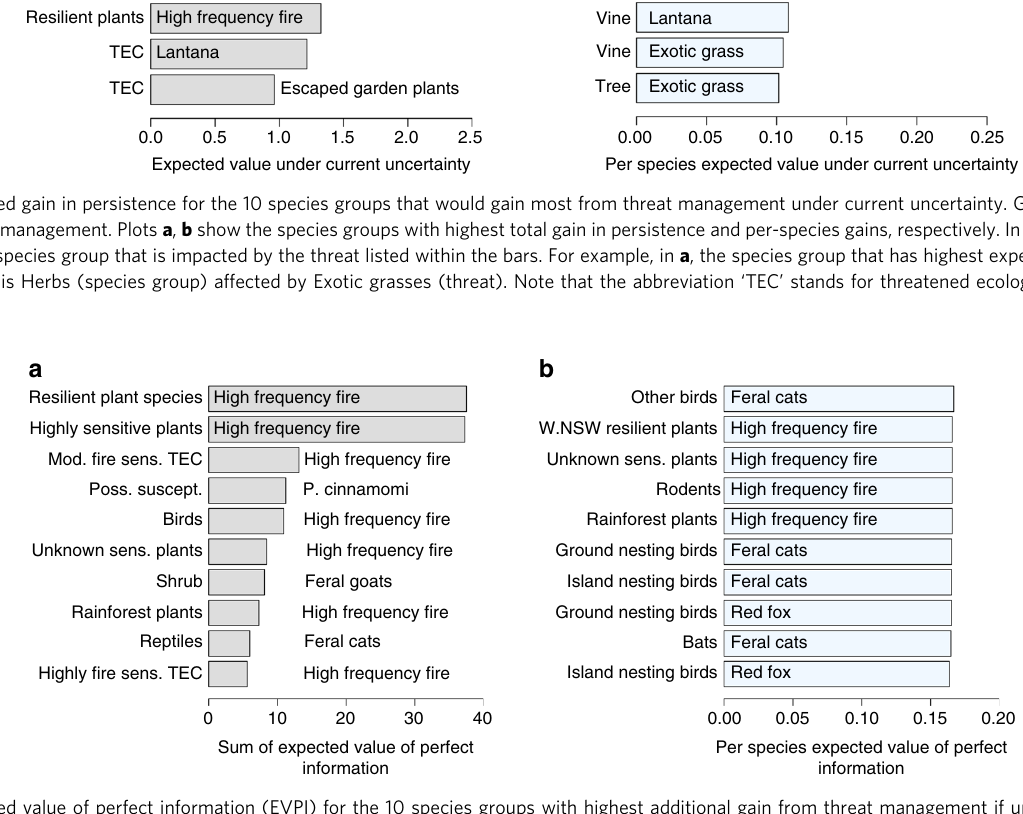
Fig. 5 Expected value of perfect information (EVPI) for the 10 species groups with highest additional gain from threat management if uncertainty about management effectiveness was removed. Additional gain is measured relative to best management under current uncertainty. Plots a , b show the 10 species groups with highest total EVPI and EVPI per species, respectively. In each plot, the y -axis lists the species group that is impacted by the threat listed within the bars. Note that the abbreviation ‘ TEC ’ stands for threatened ecological